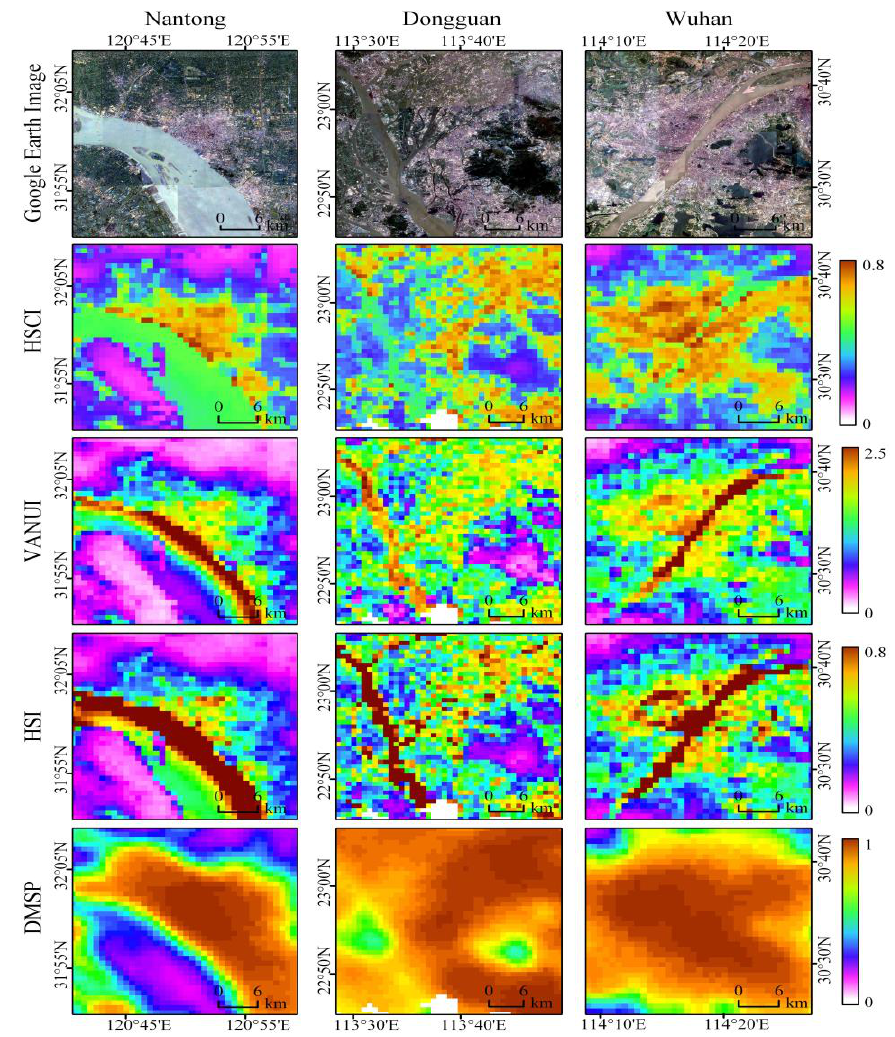
Figure 8. Comparisons of HSCI, VANUI, and HSI signals for urban water bodies in three cities.